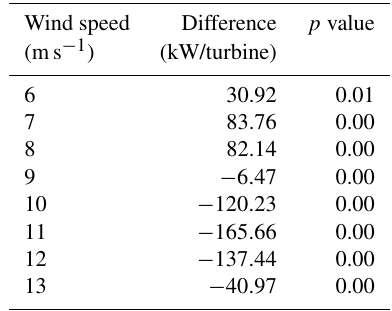
Figure 3. Comparison of the turbine-level power conversion to the super-turbine power conversion for the hypothetical wind farm with a 1ms − 1 standard deviation across the turbines. Table 1. Difference of the super-turbine power conversion sub- tracted from the turbine-level power conversion for the hypothet- ical wind farm of 100 turbines with 1ms − 1 variability simulated 1000 times. The p value indicates statistical significance at the 95% level for a two-sample related t test.